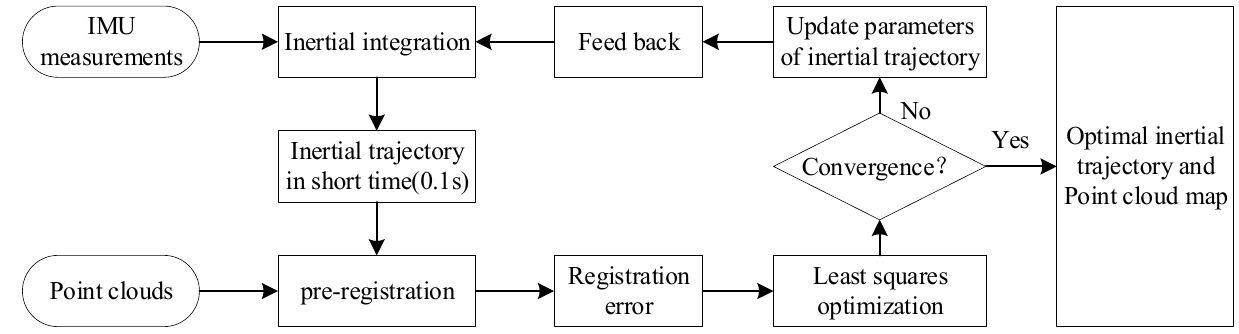
Figure 3. Flow chart of the proposed method.